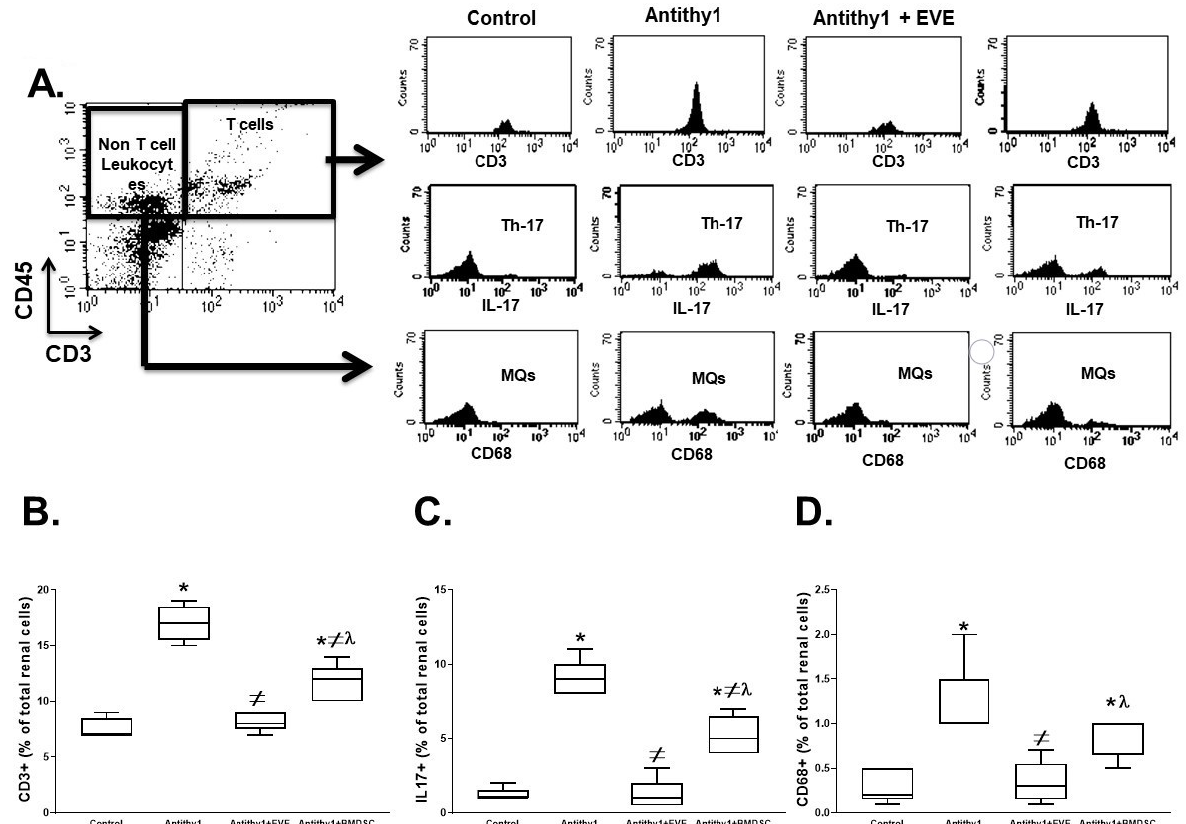
Figure 6. Representative flow cytometry plots ( A ) and % of total renal cells expressing CD3+ ( B ), IL-17+ ( C ) and CD68+ ( D ) as markers of naïve T cells, T helper cells and macrophages, respectively, in control and anti-Thy1-injected rats with or without everolimus or BMDSC treatment. Everolimus treatment prevented the elevation in T cells and IL-17 expression in anti-Thy1-injected rats. Everolimus provided better effect than BMDSCs in preventing the increase in renal macrophage infiltration in anti-Thy1-injected rats (n = 6, * vs. control, ≠ vs. anti-Thy1-injected rats and λ vs. everolimus-treated rats).